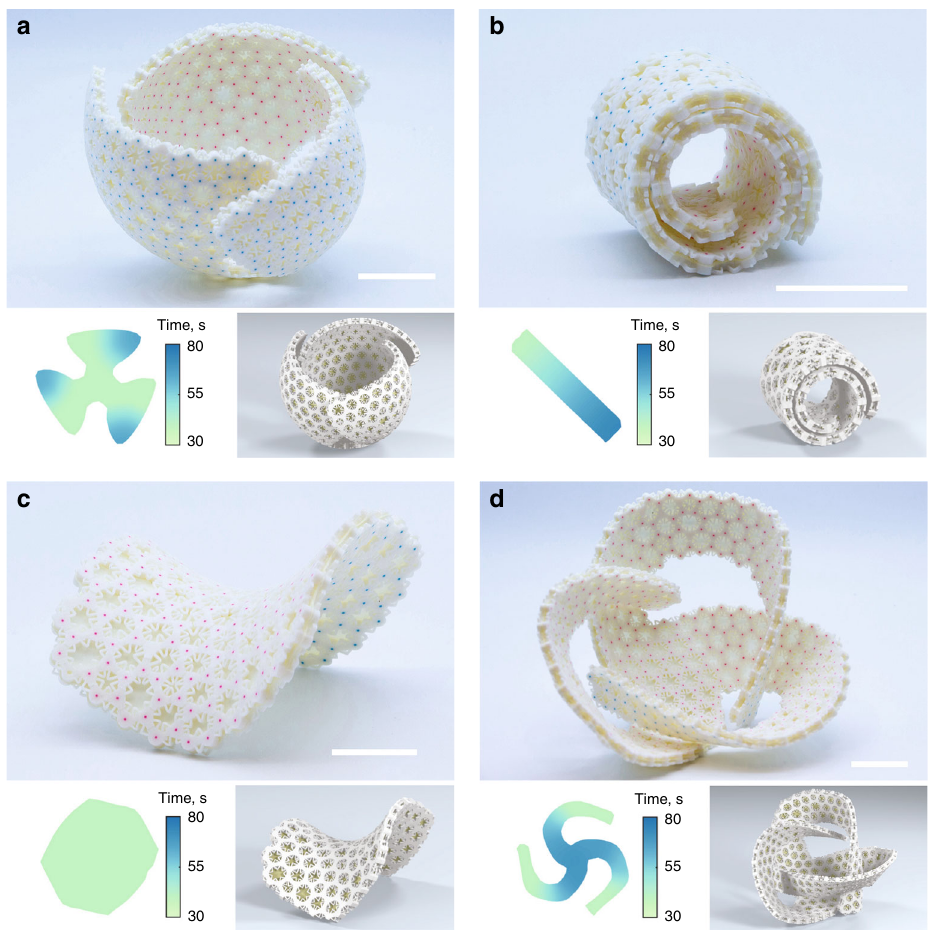
Fig. 3 Spatio-temporally programmed shells. Each panel shows a real shell (top), its actuation time landscape (bottom-left), and its corresponding simulated shell (bottom-right). a Doubly curved shell where petals morph synchronously to cover each other in a cyclic manner. One corner of each petal is programmed to morph slower to increase the distance between petals during morphing. b A double spiral that approximates a developable surface. A gradient time landscape enables the inner spiral to curl fi rst. c A saddle shape with negative curvature. d A shell with a complex self-interweaving shape prone to multiple collisions in the course of its morphing process. Scale bars, 3